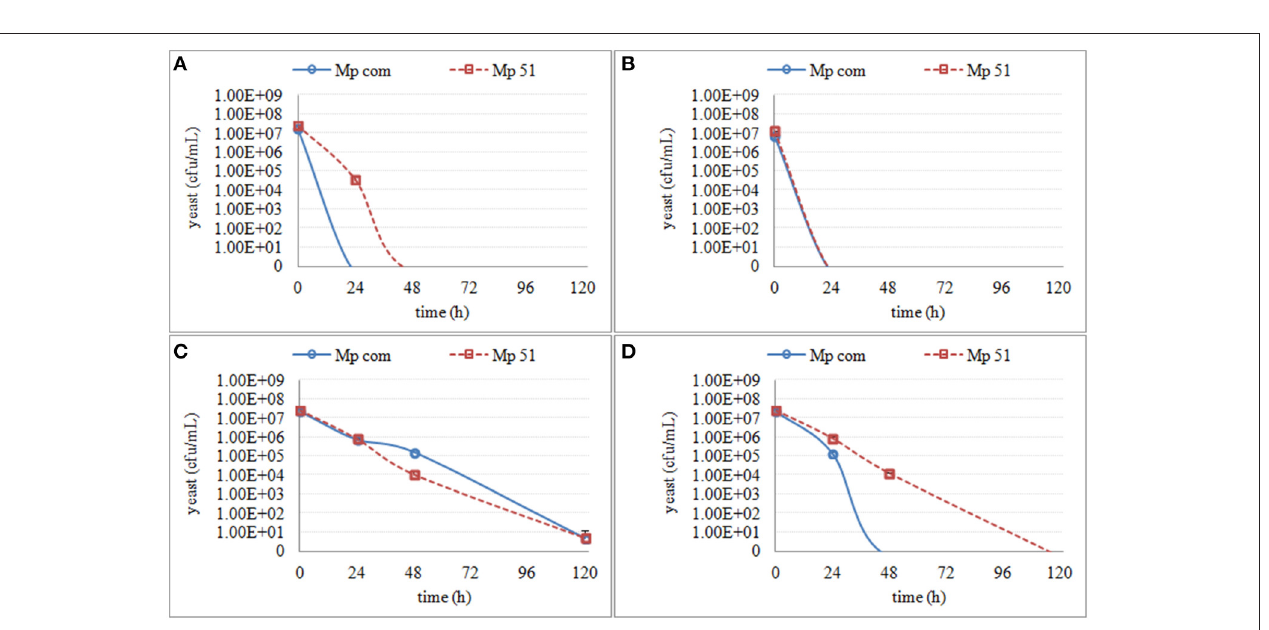
FIGURE 4 | The culturable population of two M. pulcherrima strains (Mp com and Mp 51) grown in different synthetic media for 120h. (A) the growth in supernatant from the second stage of S. cerevisiae fermentation S-2 (B) the growth in supernatant from the third stage of S. cerevisiae fermentation S-3 (C) the growth in synthetic media MS-3 (D) the growth in synthetic media